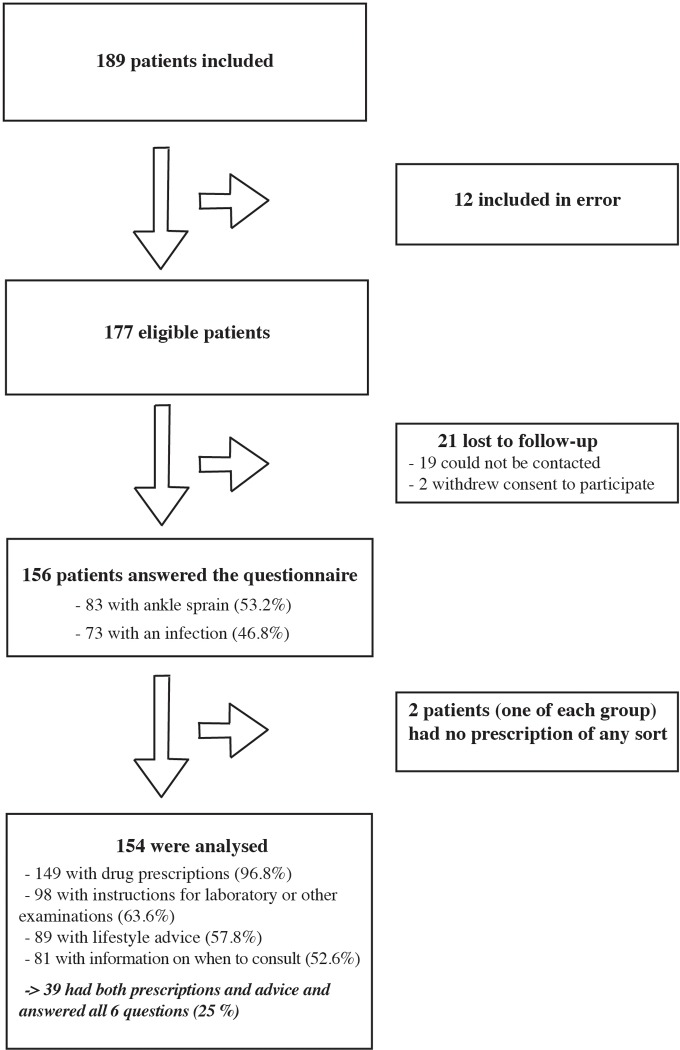
Flow-diagram for the validation of the GASAC scale.